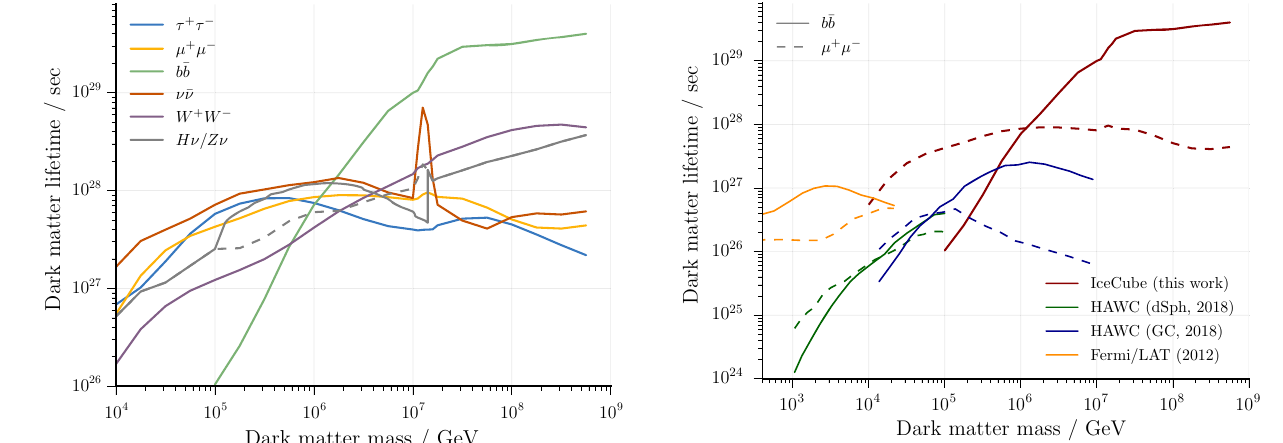
Fig. 7 Dark matter lifetime limits for all considered decay channels. For the Z + ν/ H + ν channel, the limit was combined (solid grey line) as described in the text. Between m DM ∼ 10 5 GeV and m DM = 1 . 5 × 10 7 GeV the limit is obtained from the more sensitive track analysis. The limit from the cascade analysis is shown as a dashed line and turns out to be stronger above m DM ∼ 5 × 10 7 GeV